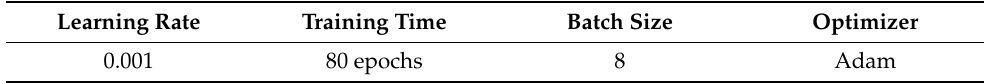
Table 1. Experimental parameter table. Learning